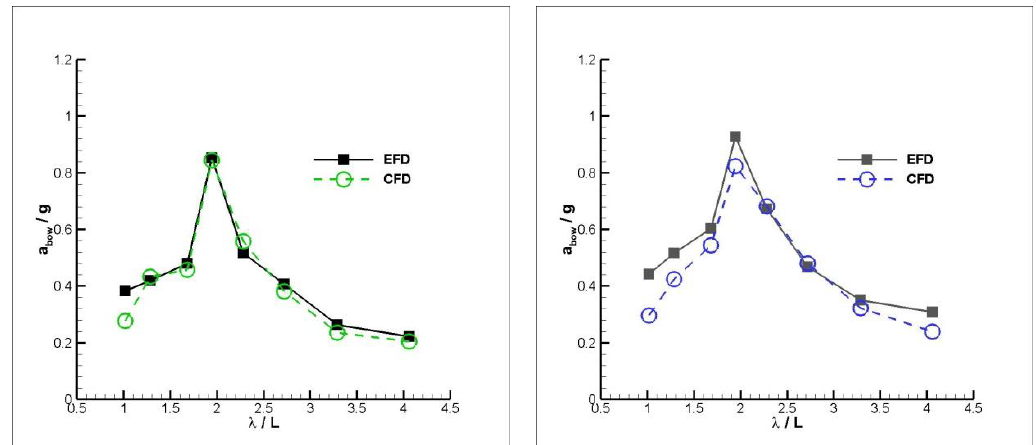
Figure 15. Bow accelerations for mono ( left ) and warped ( right ) hulls at Fn B = 1.67.